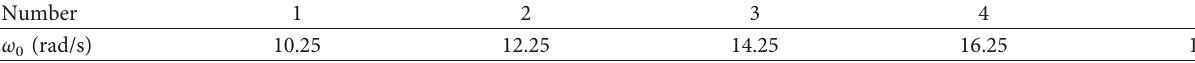
0 of the moving harmonic